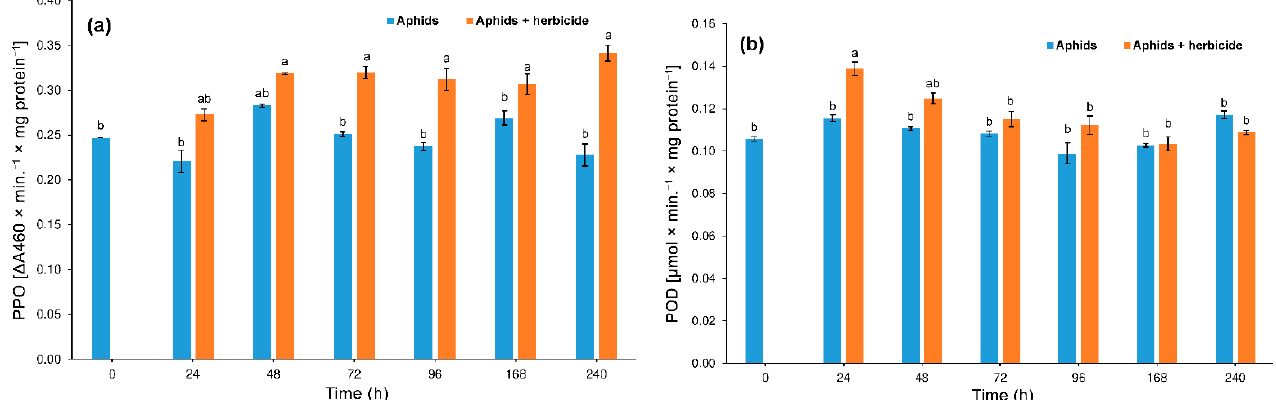
Figure 7. Activity change of polyphenol oxidase (PPO) ( a ) and peroxidase (POD) ( b ) in the tissues of Phorodon cannabis after the application of Pantera 040 EC graminicide to the hemp plant (mean ± SE; control = aphids on the Cannabis sativa ). Values not followed by the same letter are significantly different at the level of p < 0.05 (Tukey multiple range test).